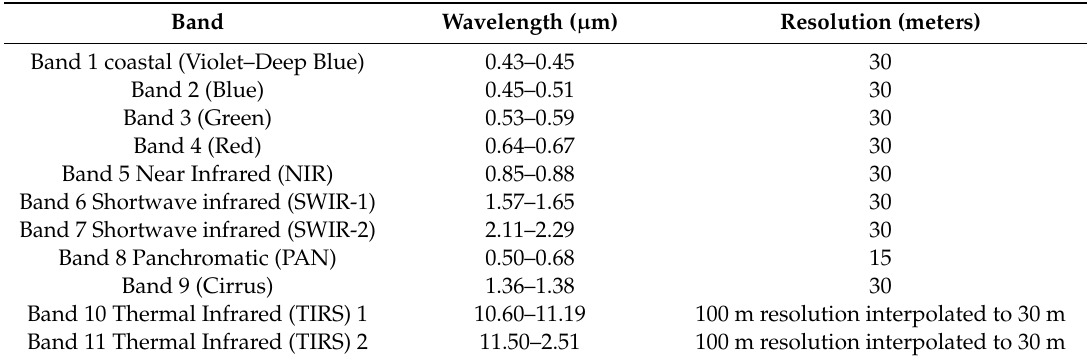
Table 2. Landsat 8 OLI band